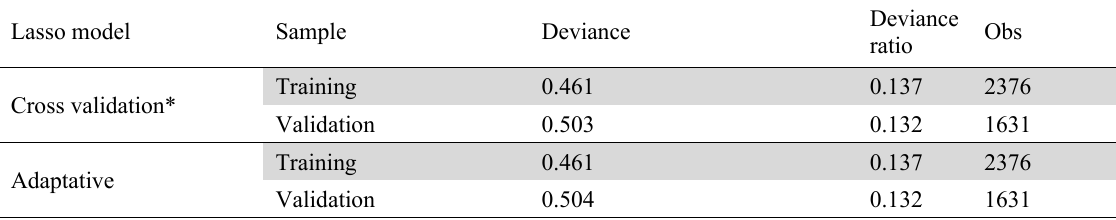
Model selection